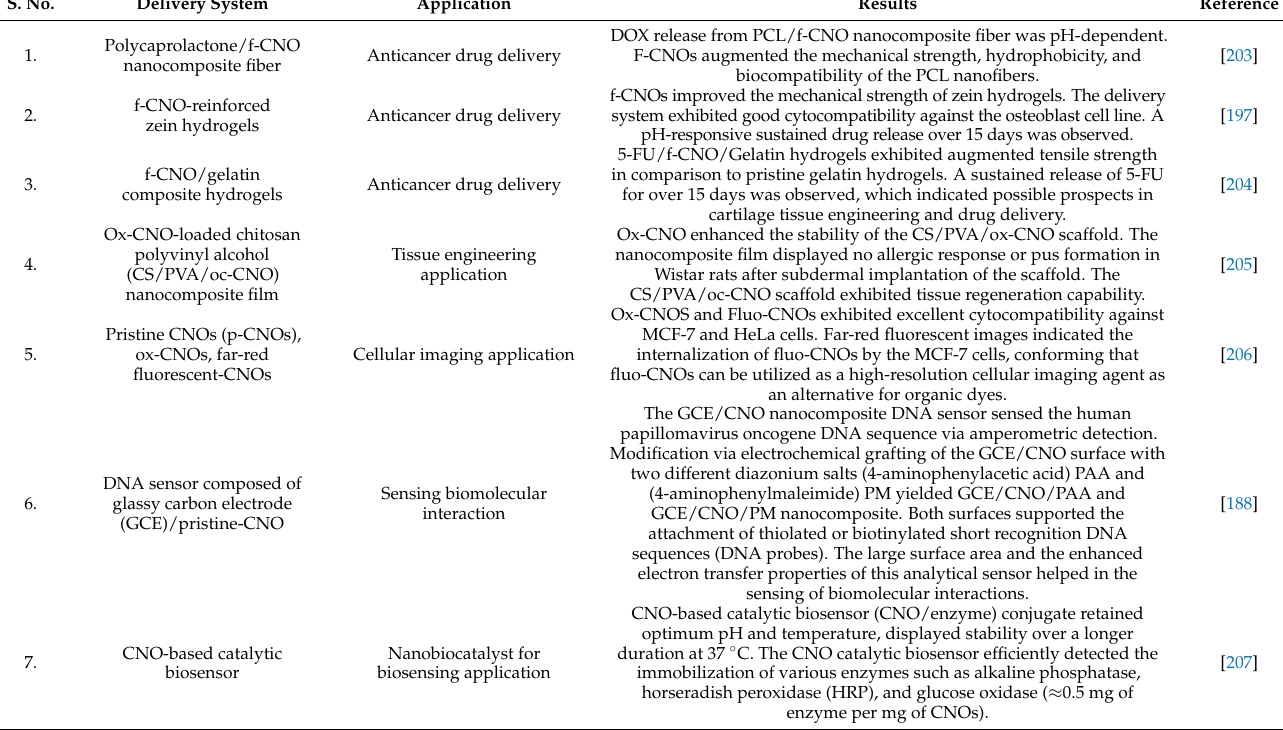
Table 5. Recent progress of CNOs in biomedical